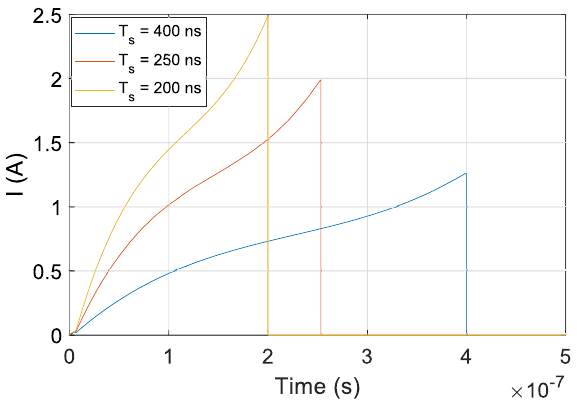
Figure 3. Current pulse waveforms for T s = 200 ns, T s = 250 ns and T s = 400 ns.